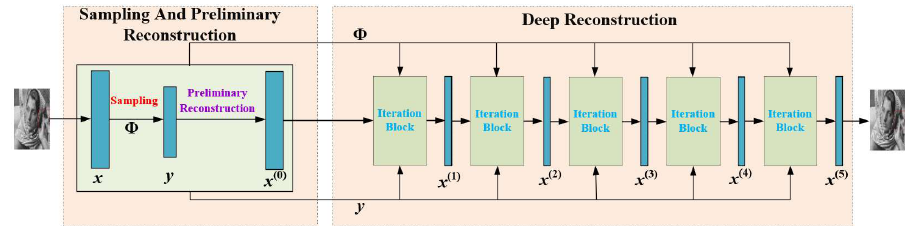
Figure 1. The network structure diagram of SRMU-Net, which consists of three subnetworks.